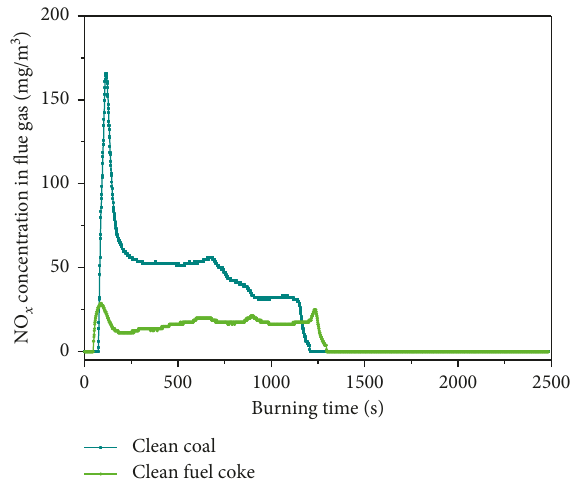
Figure 5: NO x emissions during combustion for clean coal and clean coke.